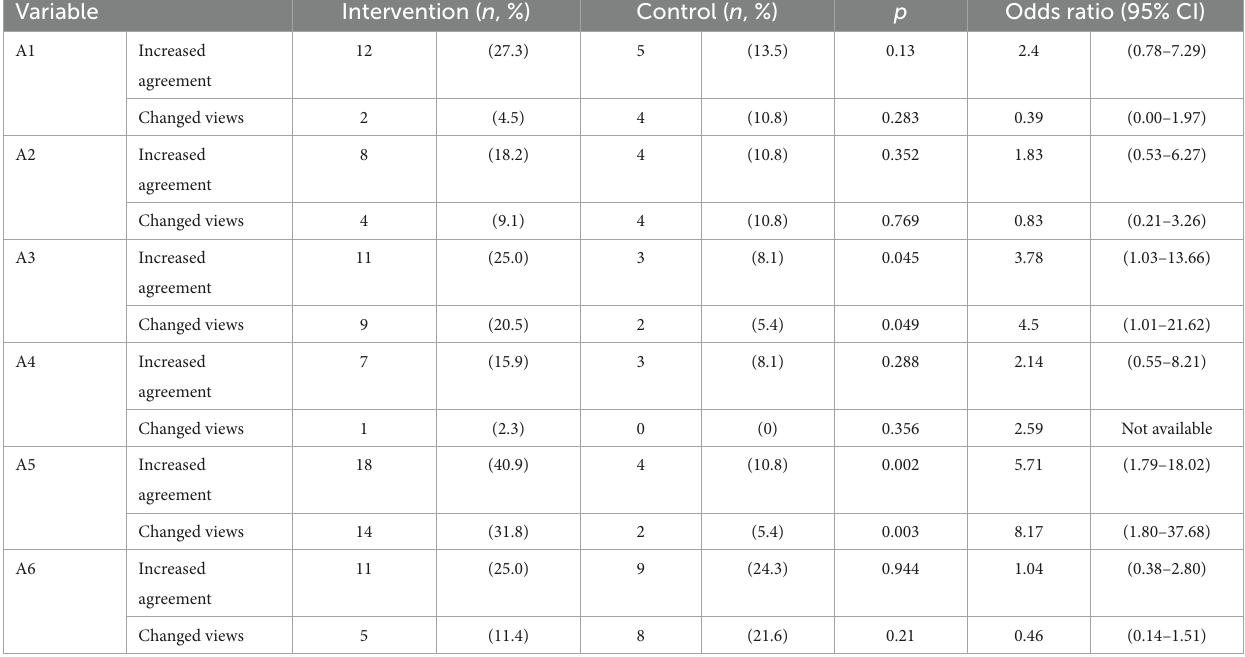
TABLE 4 Increased agreement and changed views from disagree to agree of students on regional cooperation in the intervention and control groups.